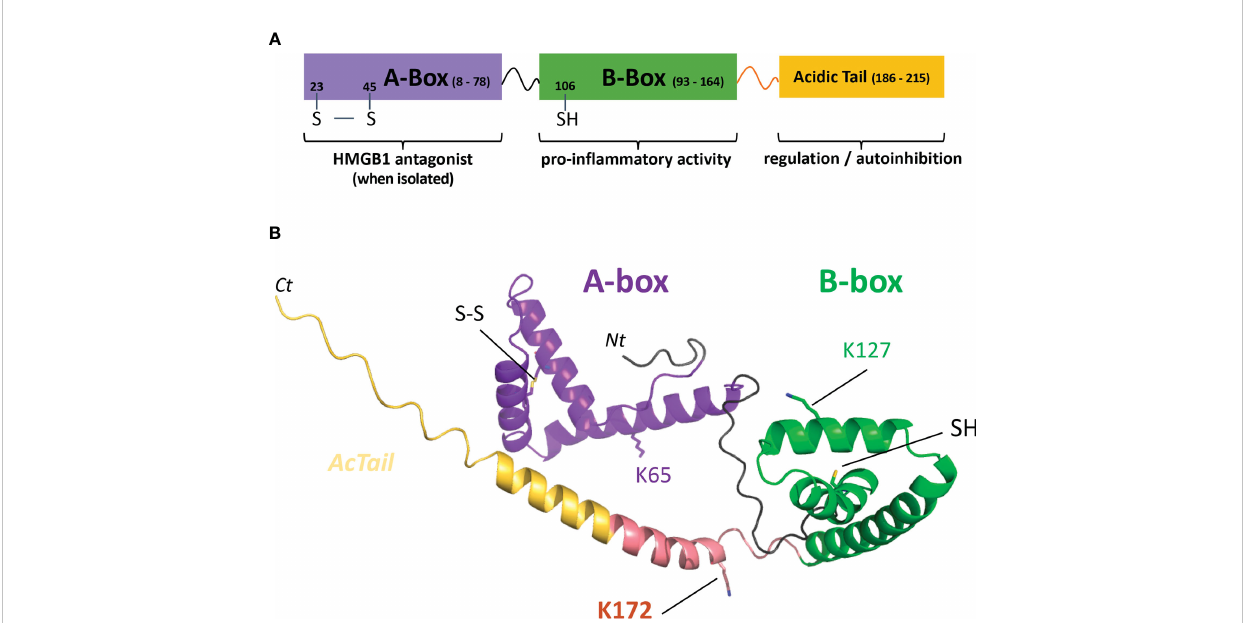
FIGURE 1 HMGB1 modular structure, C1s cleavage sites and predicted model. (A) The HMGB1 modular structure mainly includes two DNA-binding boxes, A- box (purple) and B-box (green), as well as a C-terminal negatively charged tail regulating its activity (yellow). The transition between the B-box and the acid stretch is shown in salmon pink. (B) The predicted model used was obtained from the AlphaFold Protein Structure database (26). However, it should be noted that the structure after the B-box (including the AcTail and the salmon pink transition segment) is highly uncertain and fl exible, as well as the relative orientation between the two boxes. The salmon pink region includes the main C1s cleavage site after K172, as will be shown in this study. C1s also secondary cleaves HMGB1 after K65 and K127 (lysine side chains shown in stick). The disul fi de bond between C23 and C45 in the A-box (SS) and the B-box C106 (SH) are also shown in stick. UNIPROT residue numbering is used throughout the text. Nt, Ct : chain